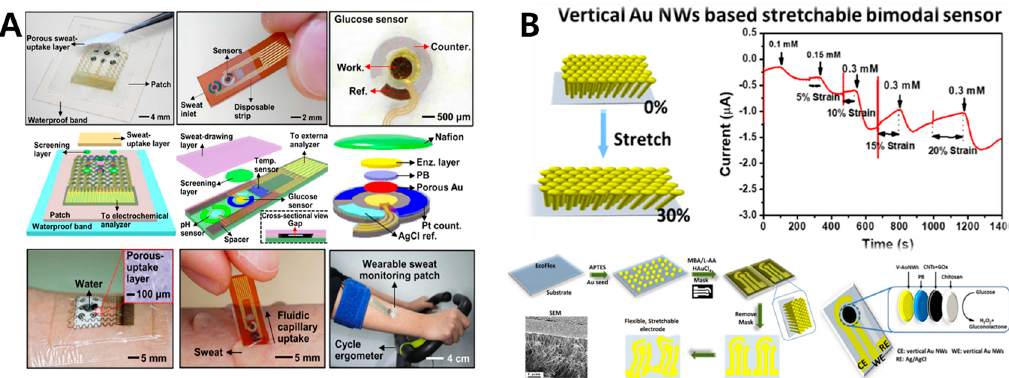
Figure 11. Sweat-based glucose monitoring. ( A ) Wearable / disposable sweat-based glucose monitoring device with multistage transdermal drug delivery module. Adapted with permission [138]. Copyright 2017, Science advances. ( B ) Enokitake mushroom-like standing gold nanowires toward wearable noninvasive bimodal glucose and strain sensing. Adapted with permission [110]. Copyright 2019, American Chemical Society.